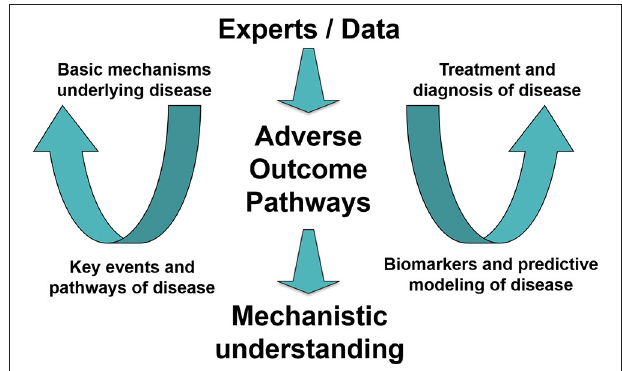
FIGURE 2 | Toward an interdisciplinary workflow and infrastructure for systematic gathering and organization of data in potential future health crises. A concept demonstrating how experts join in an interdisciplinary data-driven effort supported by the Adverse Outcome Pathway (AOP) framework to increase mechanistic understanding of disease. The gained understanding supports effective (and ideally animal-free) development of treatments and diagnostics. [Figure modified from (